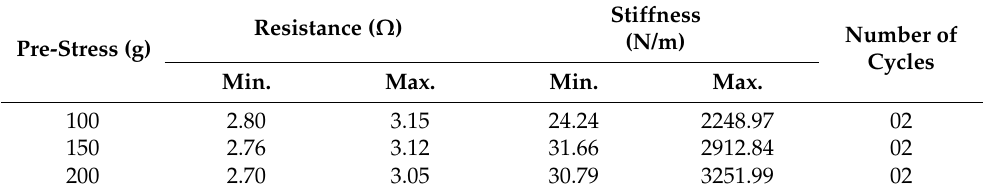
Table 15. Resistance and Stiffness at different Duty Cycles.